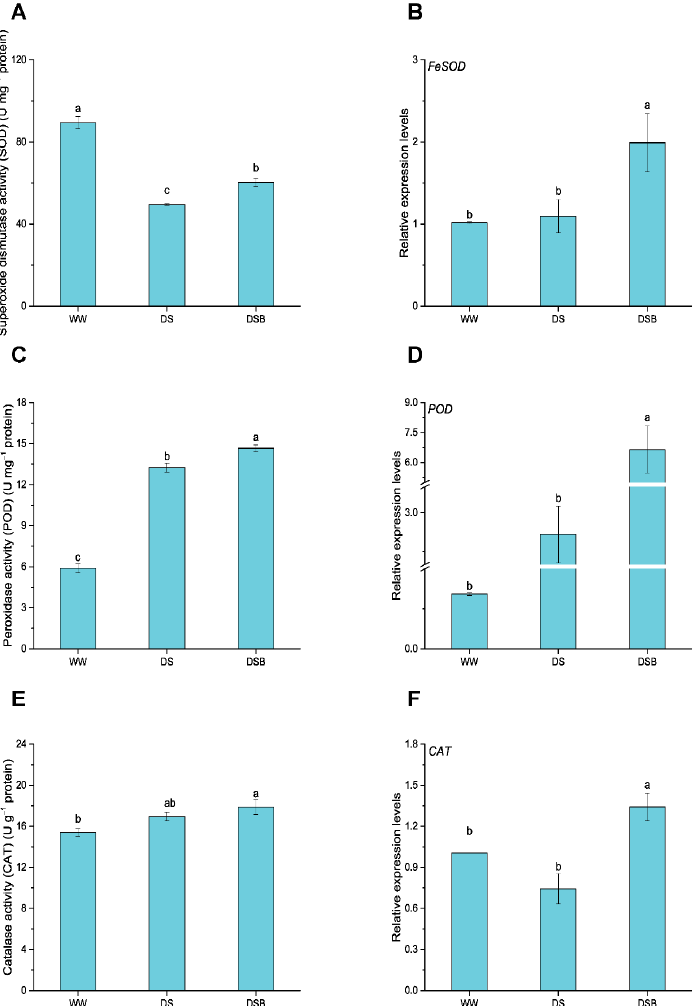
Figure 5. Antioxidant enzyme activities and their related gene expression as affected by 2,4- epibrassinolide (EBR) application under drought stress. This figure comprises SOD enzyme activity ( A ), FeSOD gene expression ( B ), POD enzyme activity ( C ), POD gene expression ( D ), CAT enzyme activity ( E ), and CAT gene expression ( F ). The data are presented as means ± SE in the three treatments including WW (well ‐ watered), DS (drought stress), and DSB (drought stress + 0.05 mM EBR application). Error bars represent SE of the mean; different letters on bars show significant differences at p < 0.05 using the LSD test.